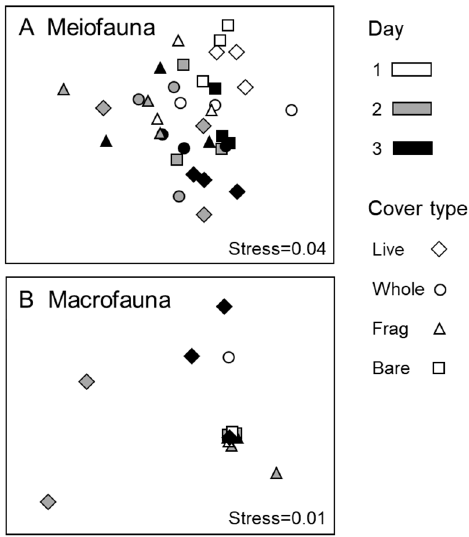
Figure 5. Nonmetric multidimensional scaling (nMDS) plots for traps: ( A ) meiofauna, ( B ) macrofauna. Table 4. ANOVA results for meiofauna in traps: relative dispersal rates (RDR). Transformations indicated where applied. Significant differences ( P < 0.05) are in bold and SNK results are presented. NAH = no alternative hypothesis; the 2 groups with the largest and smallest means within the factor were significantly different, and no further resolution among the groups in that factor could be determined. L = Live mussels, W = Whole shells, F = Fragmented shells, B = Bare sediment. D1 = Day 1, D2 = Day 2, D3 = Day 3. Meiofauna Total